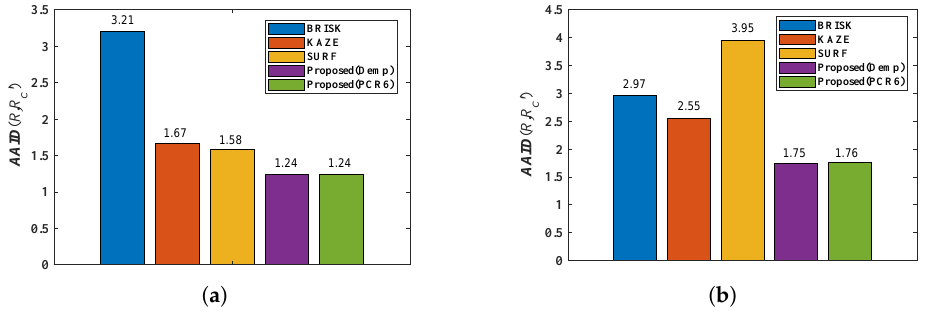
Figure 11. AAID evaluations of registration results for Boats image pair and Foosball image pair. ( a ) Boats. ( b ) Foosball.